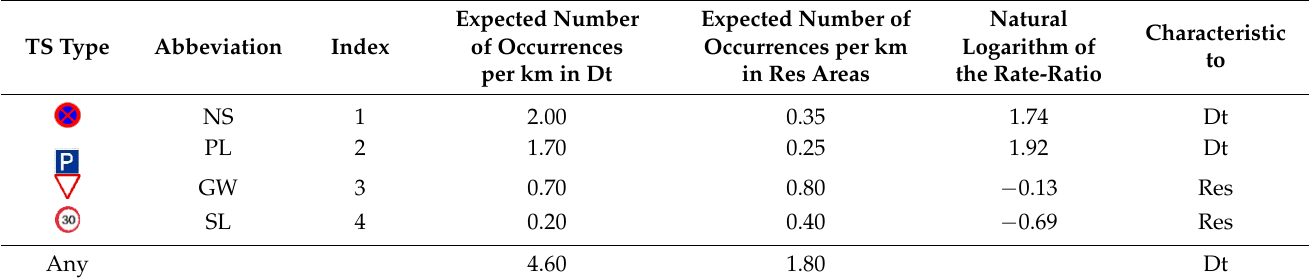
Table 1. The empirical traffic sign (TS) rates along a random route for the homogeneous marked Poisson processes describing (downtown) Dt and residential (Res) urban road environments.